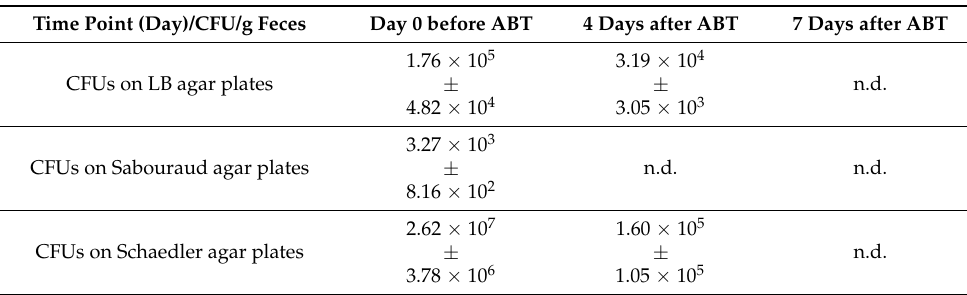
Table 3. Effect of antibiotic treatment (ABT) on the number of microorganisms per gram feces of BALB/c mice ( n = 3) at different time